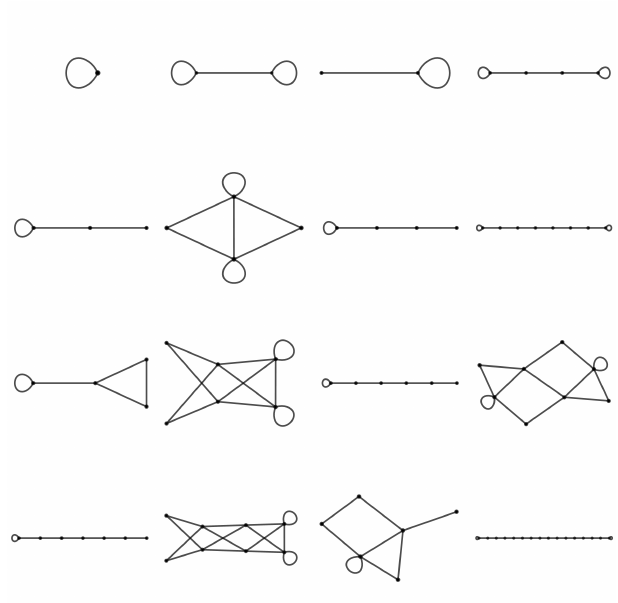
Figure 12. Antipodal condensed graphs, A p for p = 1–16. These correspond directly to the base space graphs shown in Figures 2 and